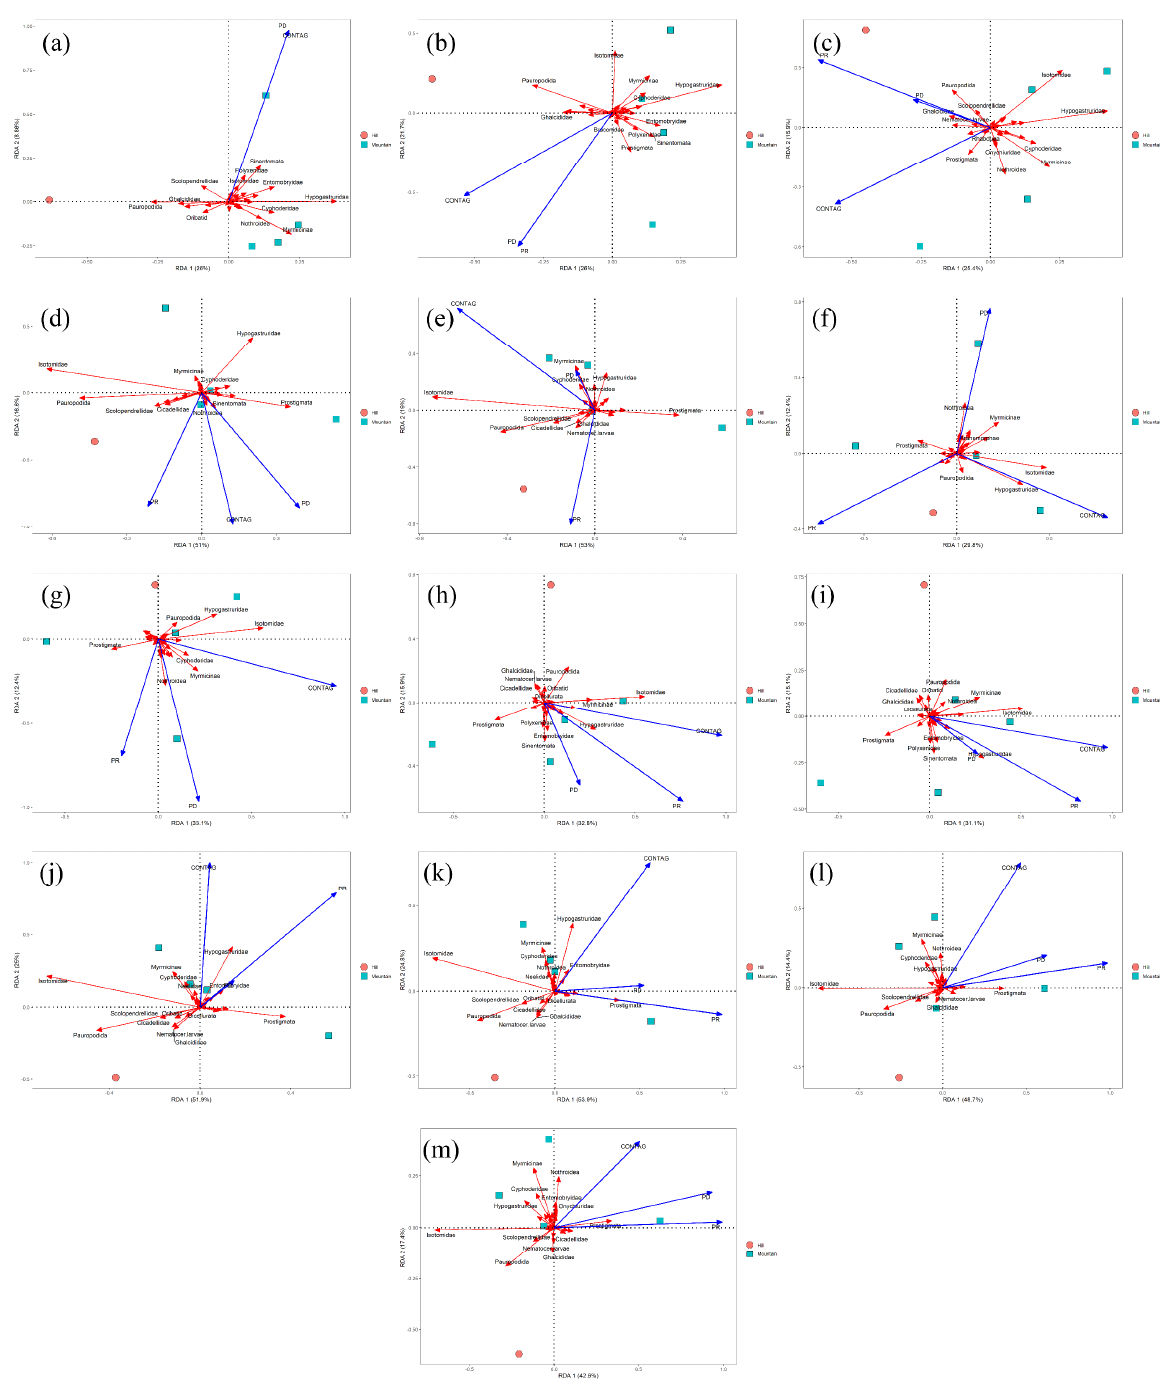
Figure A4. Ordination diagram for the RDA analysis for soil fauna distribution and landscape indices in natural forest. ( a ) 25 m buffer radius. ( b ) 50 m buffer radius. ( c ) 75 m buffer radius. ( d ) 100 m buffer radius. ( e ) 125 m buffer radius. ( f ) 150 m buffer radius. ( g ) 175 m buffer radius. ( h ) 200 m buffer radius. ( i ) 225 m buffer radius. ( j ) 250 m buffer radius. ( k ) 500 m buffer radius. ( l ) 750 m buffer radius. ( m ) 1000 m buffer radius.